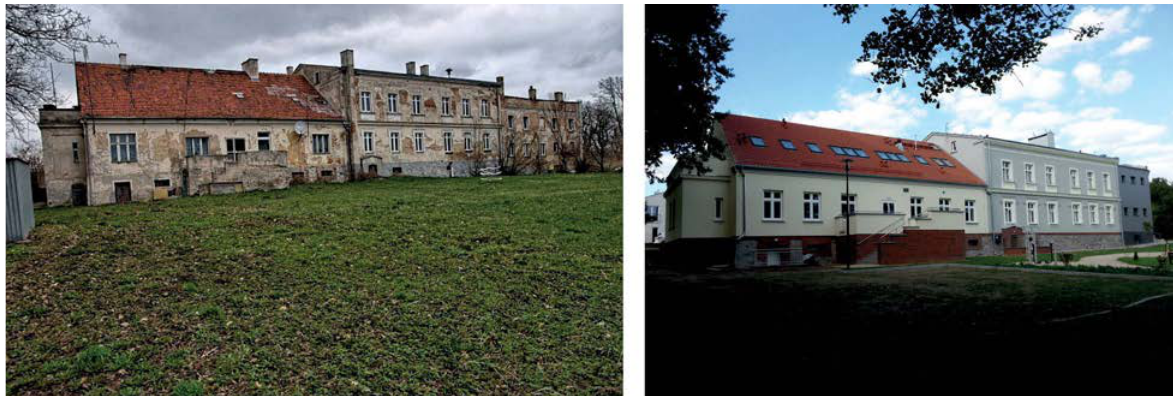
Fig. 9. Manor in Lusówko before and after